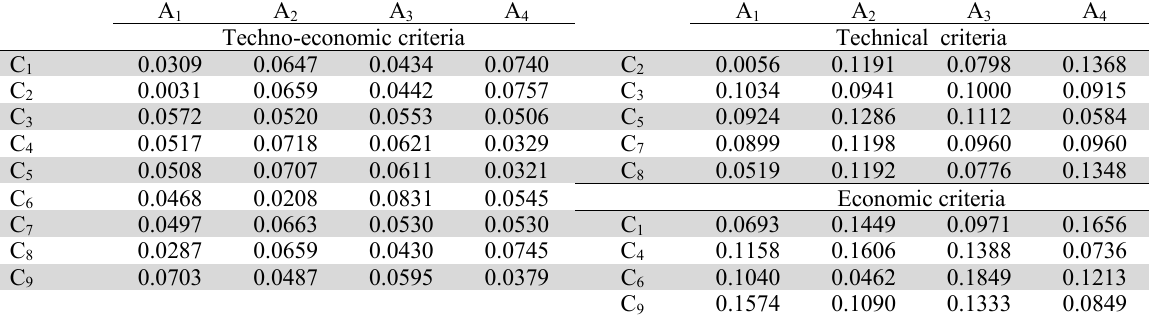
Weighted normalised values for technical, economic and techno-economic decision